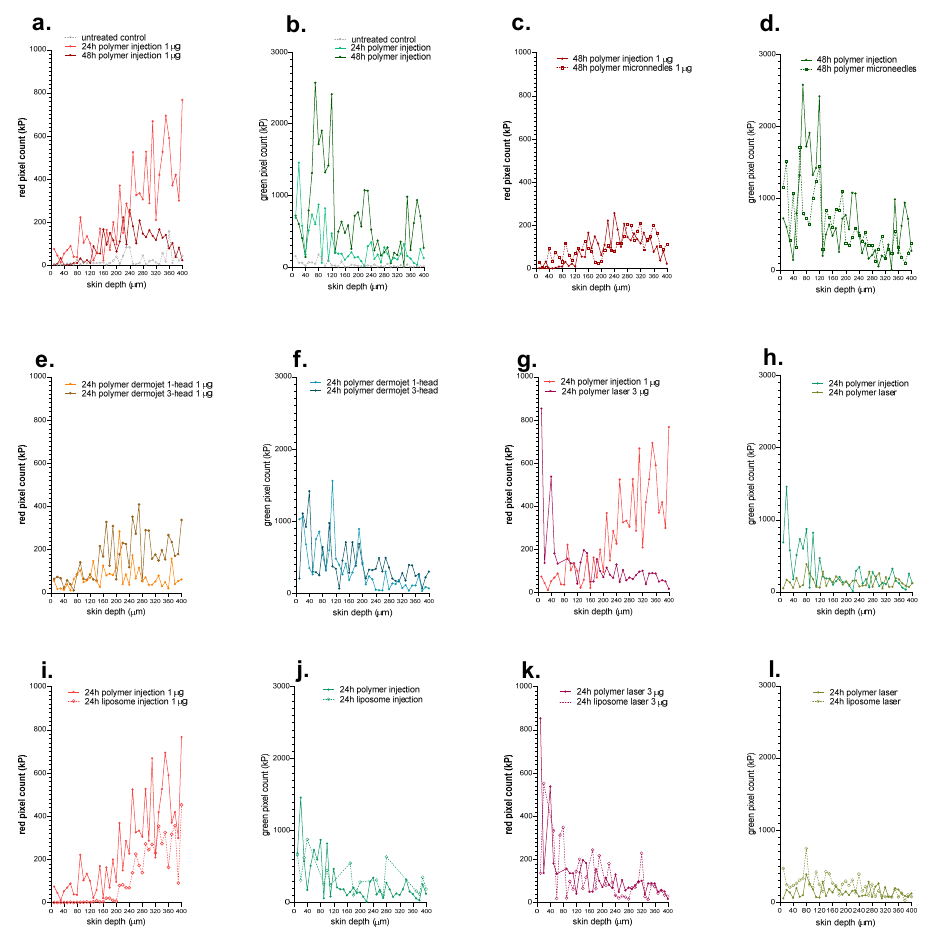
Figure 7. Semi-quantitative analysis of the delivery of Cy5-labeled mRNA and eGFP expression following delivery of eGFP expressing mRNA using the different delivery technologies. The pixel count as a function of depth was used to provide a measure of the delivery of Cy5-labeled mRNA ( a , c , e , g , i , k ) and the extent of eGFP expression ( b , d , f , h , j , l ) achieved using the different delivery technologies and experimental conditions. ( a , b ) temporal variation of Cy5 labeled mRNA and eGFP expression after ID injection shows opposite trends—loss of Cy5 labeled mRNA with time, especially in the dermis, but a significant increase in eGFP expression. ( c , d ) Confirmation that intradermal delivery with the MicronJet™600 hollow microneedle injector is similar to an intradermal injection. ( e , f ) The use of the Dermojet ® 3-head system appeared to deliver more Cy5 labeled mRNA to the dermis, but eGFP expression was similar. ( g , h ) show the striking difference in delivery of Cy5 labeled mRNA and eGFP expression following administration by ID injection and after fractional laser ablation; Cy5 labeled mRNA is present principally in the dermis after the former and in the superficial epidermis with the Iatter. ( i , j ) comparison of polymeric and liposomal transfection agents on the delivery of Cy5 labeled mRNA using ID injection. Although the trends are similar with increasing signal found in the dermis, delivery of Cy5 labeled mRNA using the polymeric formulation appears to be better and is significantly greater in the epidermis and upper dermis. In contrast, despite mRNA delivery targeting the dermis, the eGFP signal was far more intense in the epidermis, suggesting that mRNA was diffusing post-delivery as this was the principal site of protein expression. ( k , l ) comparison of polymeric and liposomal transfection agents on delivery of Cy5 labeled mRNA using fractional laser ablation; trends were similar with Cy5 labeled mRNA predominantly found in the superficial epidermis and decreasing with depth, whereas eGFP expression was low and more constant throughout (images shown in Figure 5 suggest that it occurred in proximity to the micropores but that it was possible for mRNA to also be expressed in the